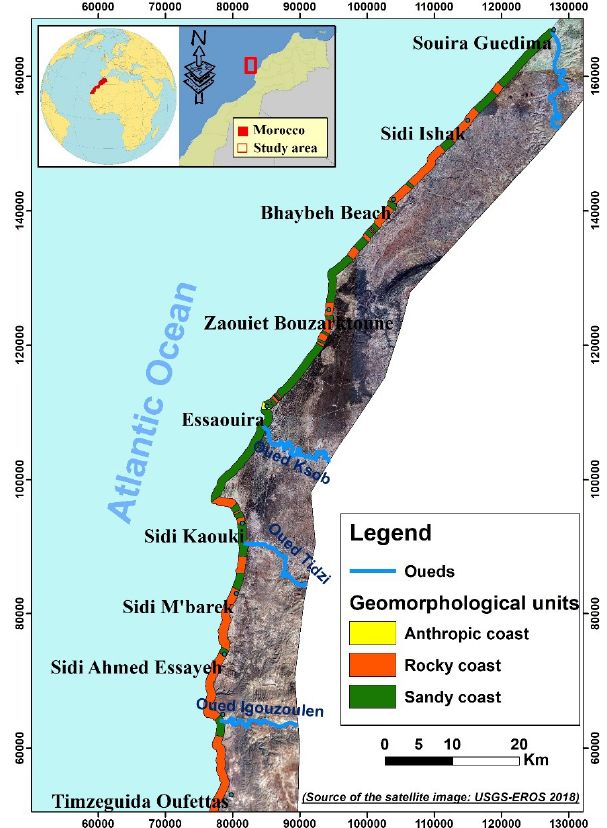
Figure 1. Geographic location of Essaouira coastal area and its sandy and rocky coast subsystems (coordinate systems: Lambert Zone I